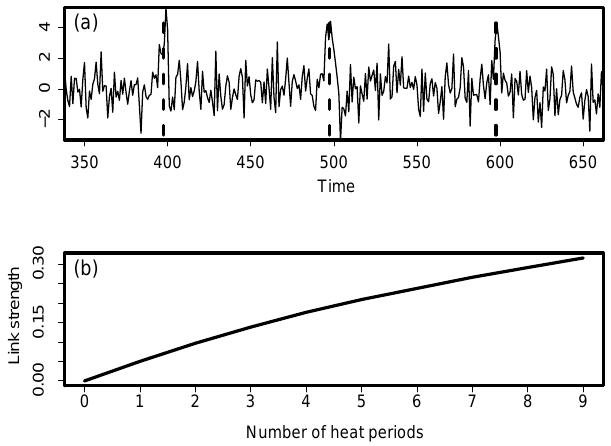
Figure 3. (a) Artificial time series including three heat periods (dashed lines). (b) Relation between the network link strength and the number of heat periods, based on 100 artificial time series.